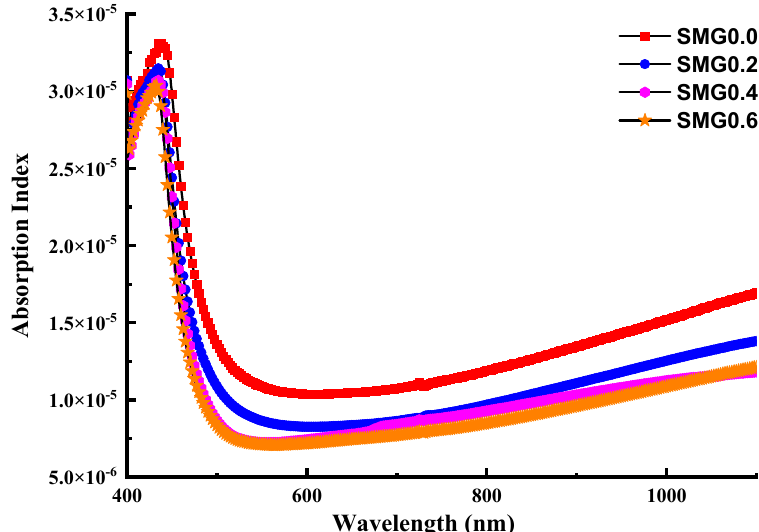
Figure 7. Absorption index of glass samples as a function of wavelength.